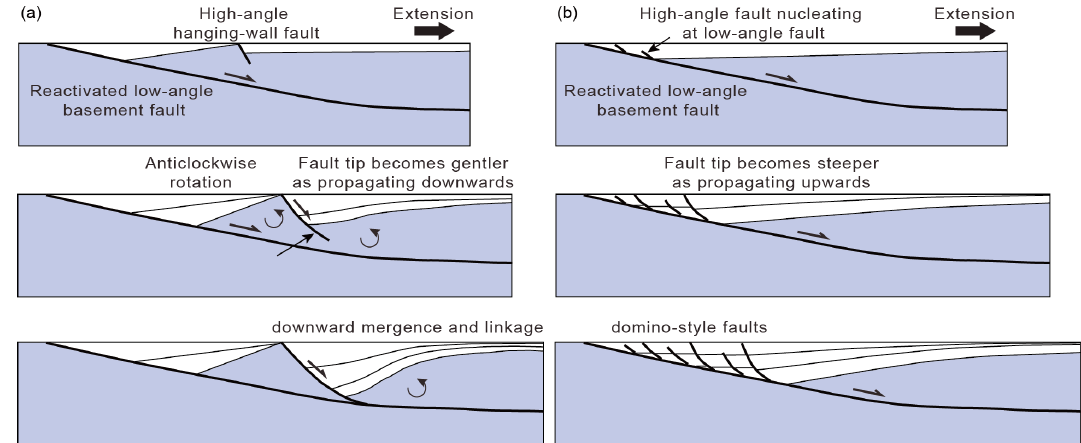
Figure 12. Model of fault evolution between a reactivated basement thrust and newly formed high-angle normal faults during rifting. (a) “Decoupled model” where a reactivated thrust fault and nearby new faults are initially isolated, followed by a later stage of vertical propa- gation and final linkage to form a connected fault system. (b) “Coupled model” where new faults nucleate at a reactivated fault and grow as kinematically related components of a fault array, where the reactivated thrust fault serves as a nucleation site for new